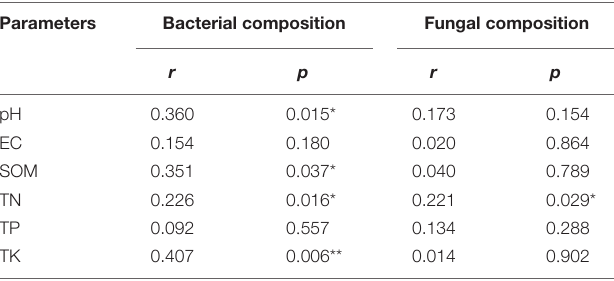
TABLE 3 | Mantel test results for correlations between soil chemical properties and bacterial and fungal community composition at the OTU level.